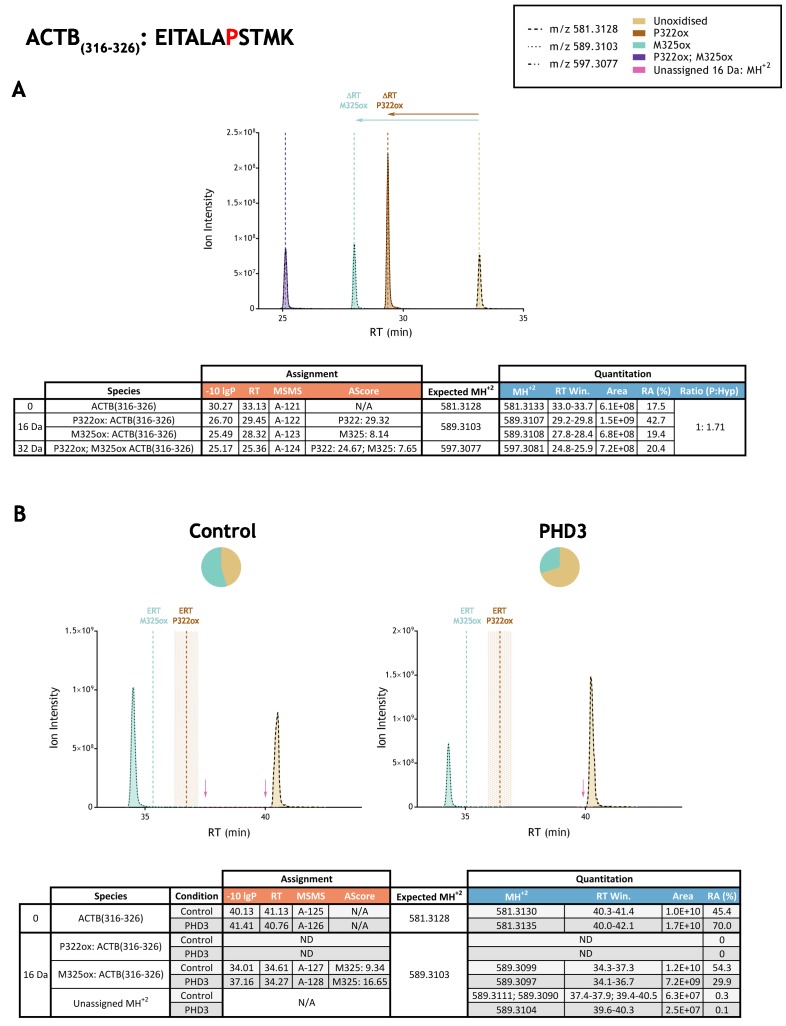
Quantitation of peptide oxidation on ACTB(316-326) following reaction of full-length beta-actin with recombinant PHD3.XIC data presented in (A) shows ion intensity and retention time (RT) characteristics of equimolar synthetic peptide standards for unoxidised and P322ox forms of the ACTB(316-326) peptide. MSMS assigned species are coloured (see inset) and include non-enzymatic methionine oxidation (M325ox; turquoise); vertical dashed lines define peak maxima used to derive ΔRT values for P322ox and M325ox. Panel (B) shows comparable XIC data for protease-digested IVTT substrate under control (left) or PHD3-reacted (right) conditions. Peaks corresponding to unoxidised and M325ox forms of ACTB(316-326) were assigned by MSMS (see inset for colour code); P322ox was not detected. Estimated RT (ERT) values for oxidised peptides, derived from (A), are indicated by dashed vertical lines and show IVTT-derived M325ox eluting close to the ERT; shading applied to ERT P307ox corresponds to a 1 min RT window. Peptide ions of low abundance that were compatible with oxidation but not assigned by MSMS are also indicated (pink arrow). Quantitative data for observed species are presented as pie charts with XIC data. Assignment and quantitation data are tabulated below each panel, table headers are as follows: (−10lgP) significance score of leading assignment at given (RT) with ambiguity score (AScore) for PTM localisation and reference to primary MSMS data in Supplementary file 1. Quantitative data reports ion counts (Area) of observed masses (MH+2) integrated over time (RT Win.), expressed as relative abundance (RA). Data on detection efficiency for synthetic peptides (Panel A, P: Hyp) is an aggregated ratio of prolyl (P) to hydroxyprolyl (Hyp) containing species.